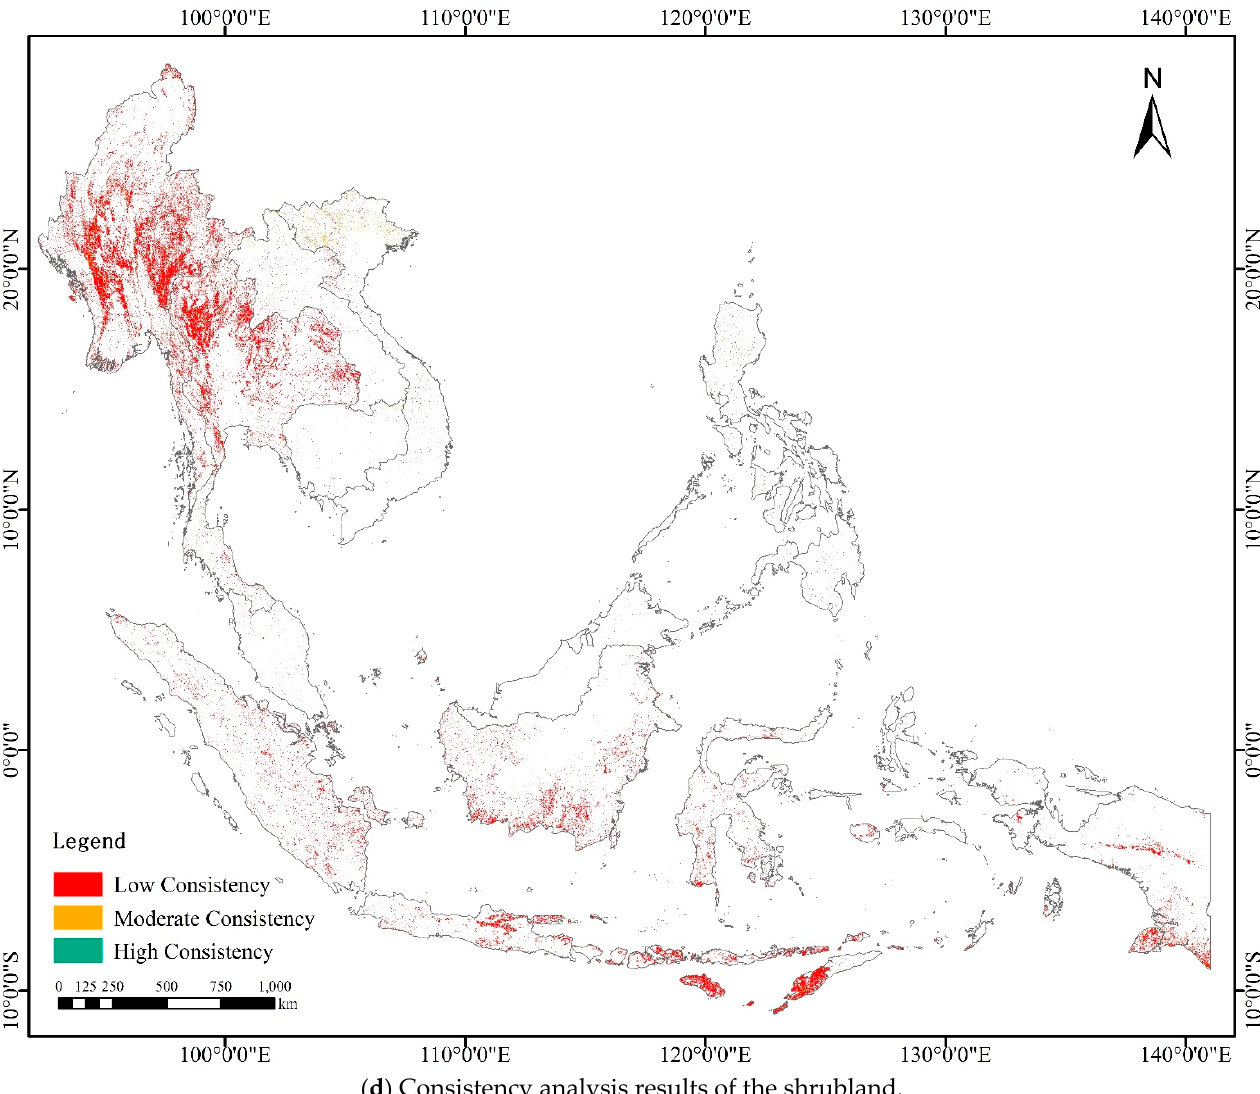
( d ) Consistency analysis results of the shrubland. Figure A1. Cont